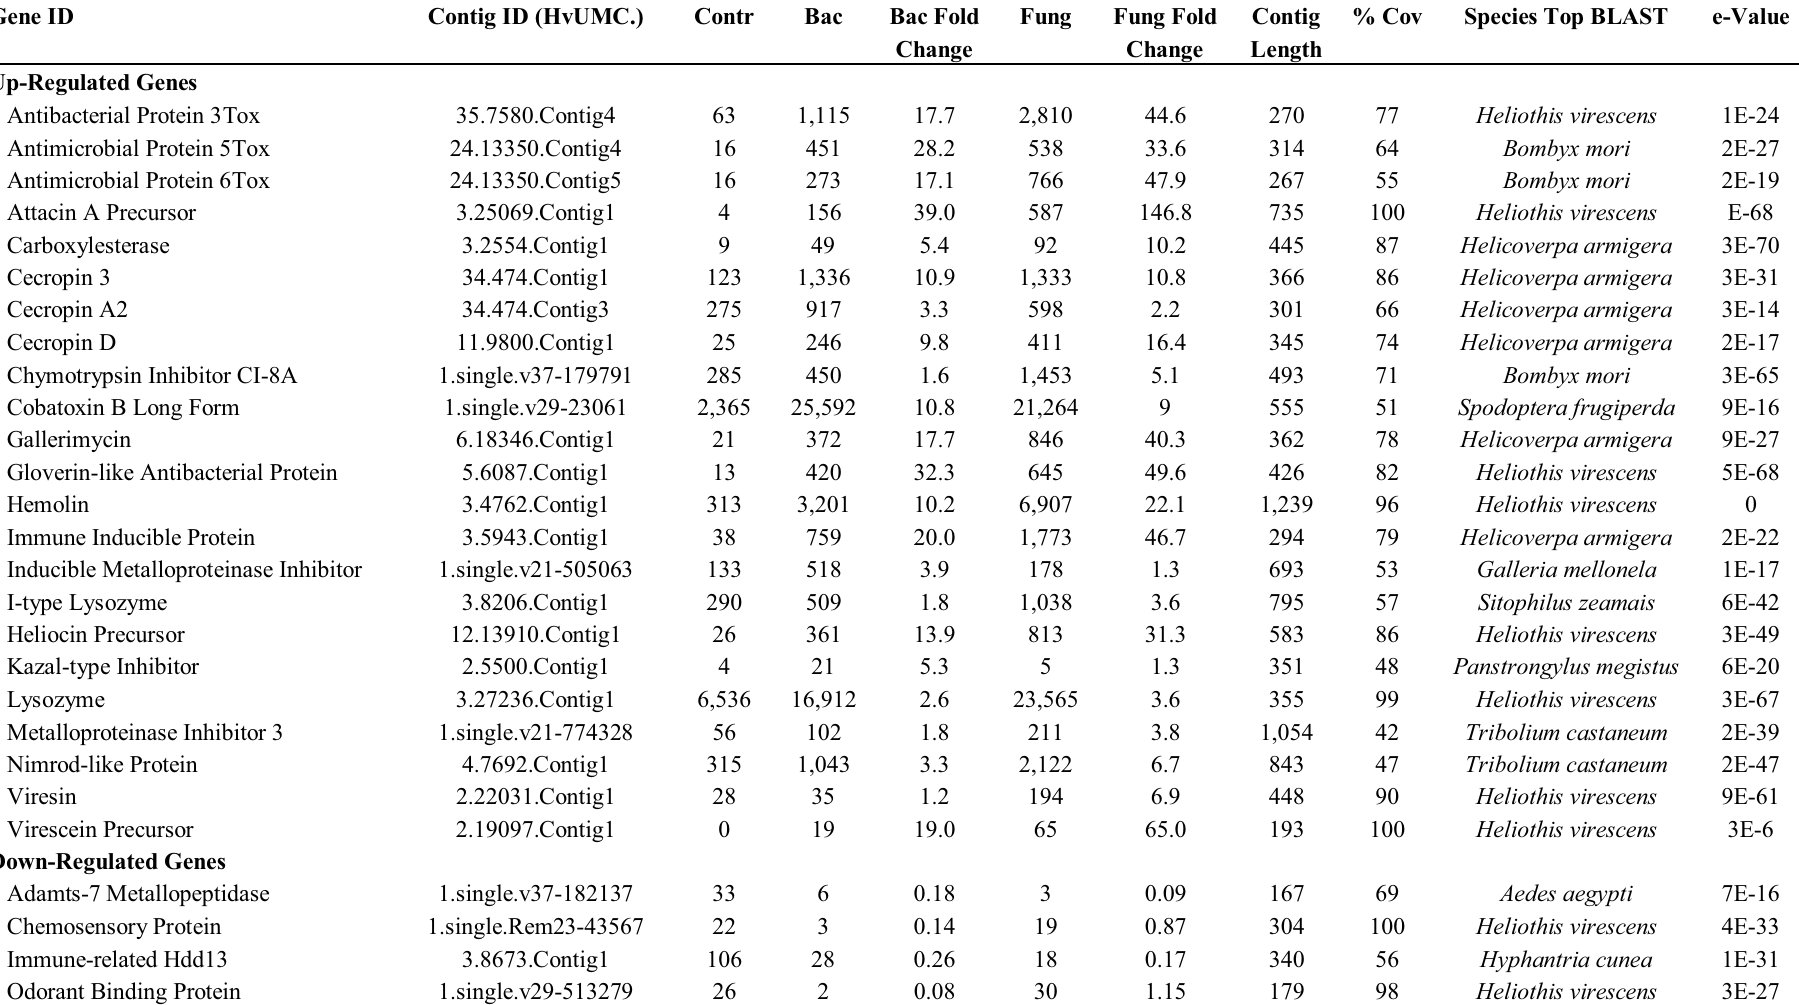
Table 3. Antimicrobials And